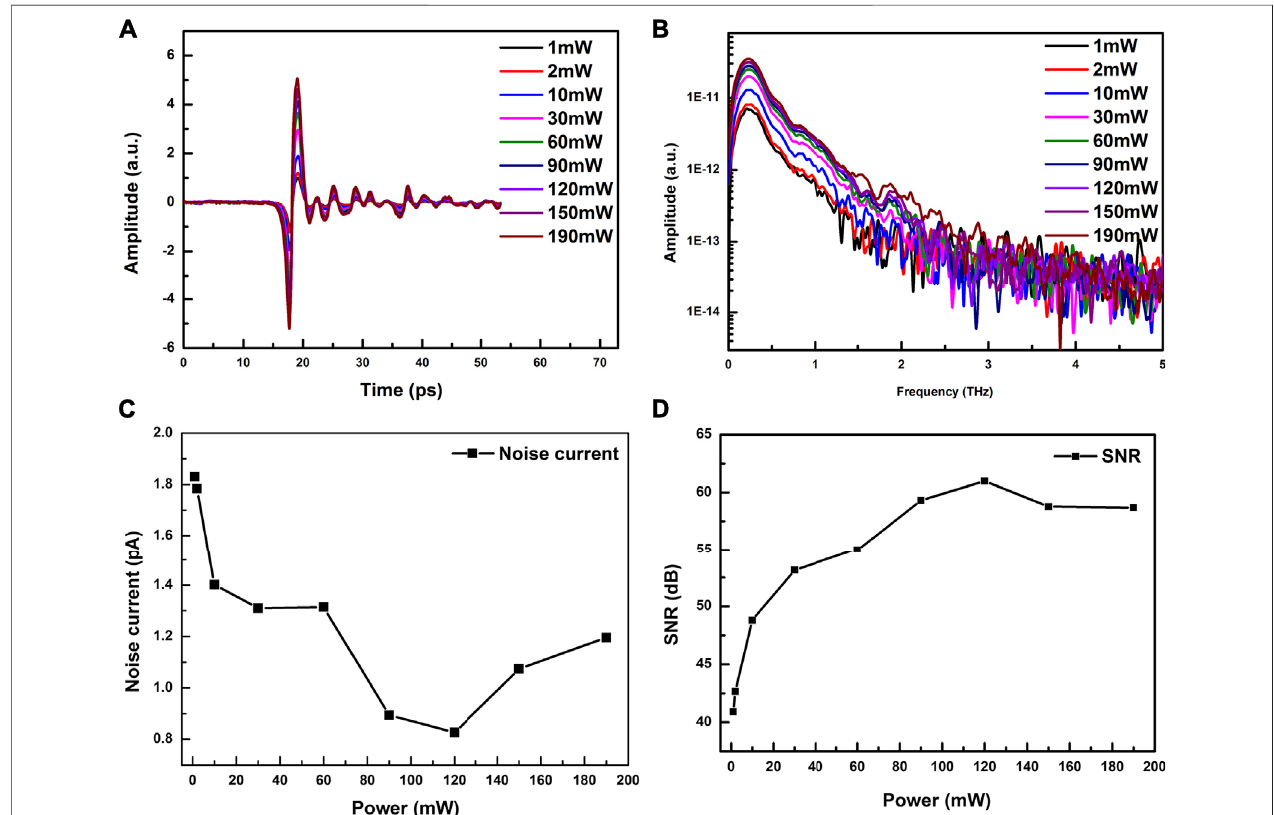
FIGURE 3 | The response of the PCA array detector under different probe power. (A) Time-domain spectrum; (B) Frequency domain spectrum; (C) The noise current of the PCA array detector; (D) SNR of the PCA array detector.